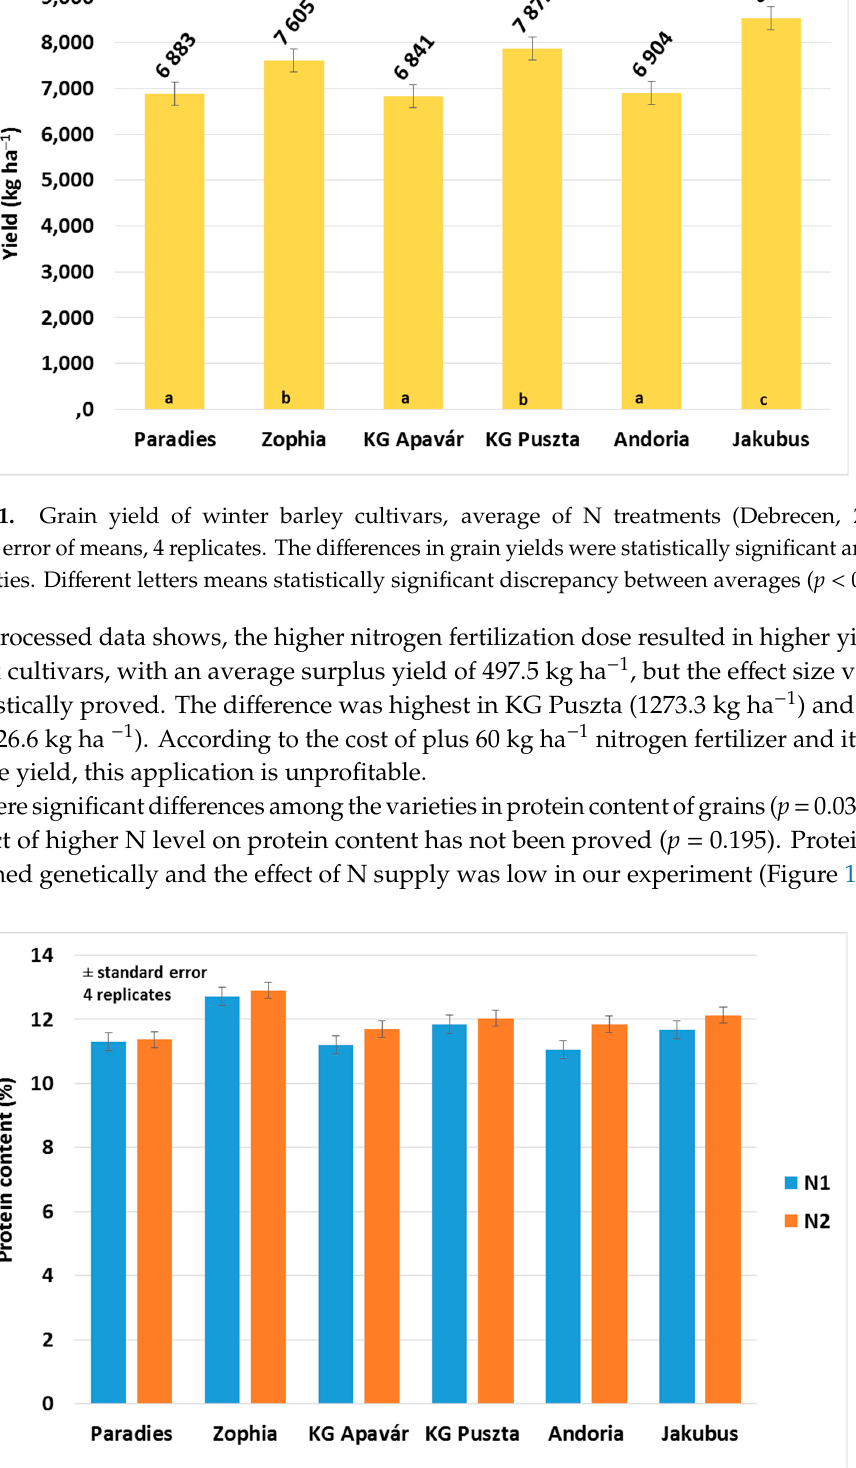
Table 6. Protein yield of winter barley cultivars (2020, Debrecen) Nitrogen Dose (kg ha − 1 )